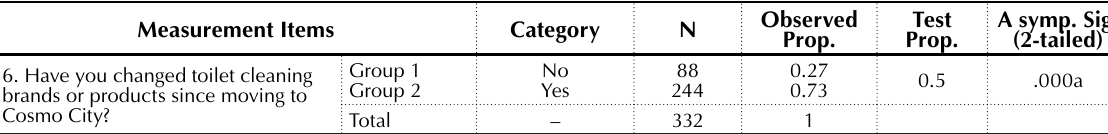
Table 5. Brand switching – binominal test results